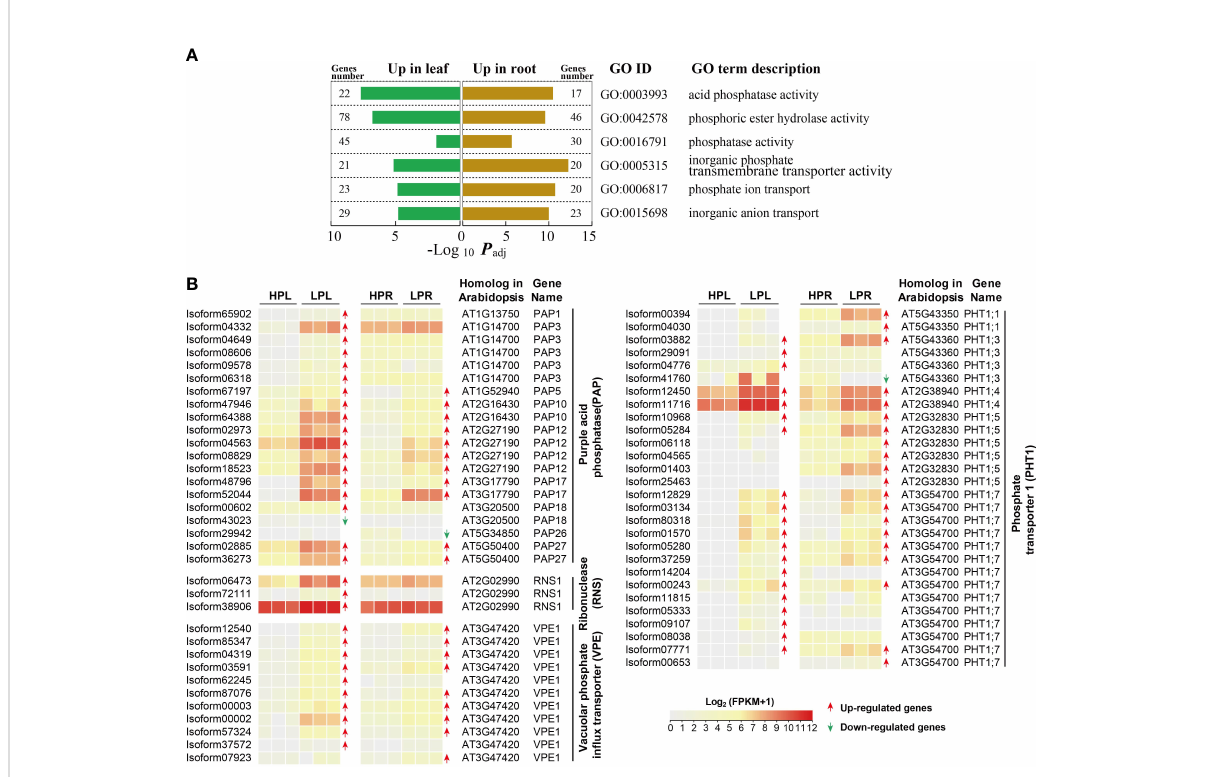
FIGURE 3 Expression changes of unigenes associated with Pi acquisition and transport in elephant grass upon Pi deprivation. (A) The signi fi cantly enriched KEGG pathways and GO terms associated with differentially expressed phosphate acquisition and transport-related unigenes. (B) Differentially expressed unigenes encoding purple acid phosphatase (PAP), ribonuclease (RNS), vacuolar phosphate in fl ux transporter (VPE), and phosphate transporter 1 (PHT1) in leaves and roots of elephant grass under Pi